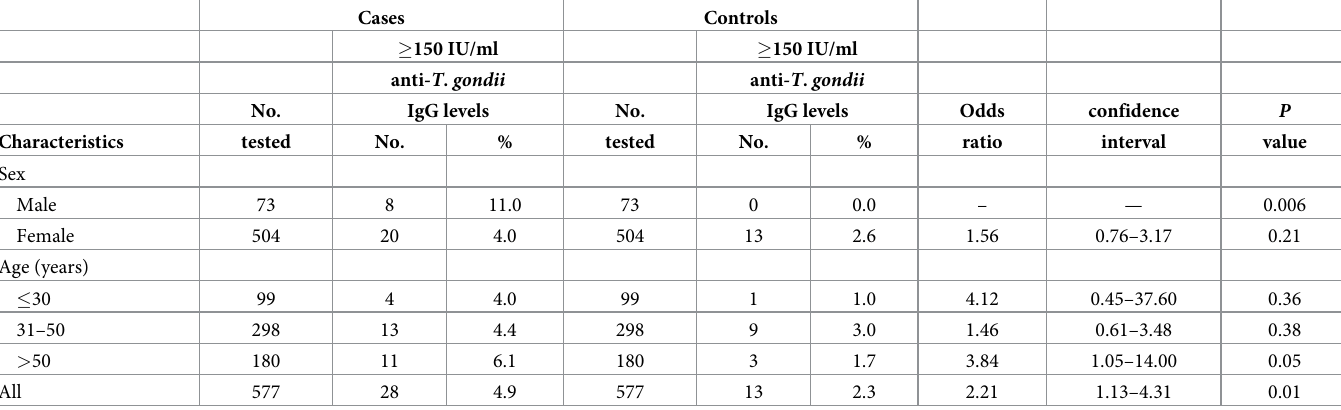
Table 2. Stratification by sex and age in cases and controls and rates of high ( � 150 IU/ml) anti- T . gondii IgG antibody